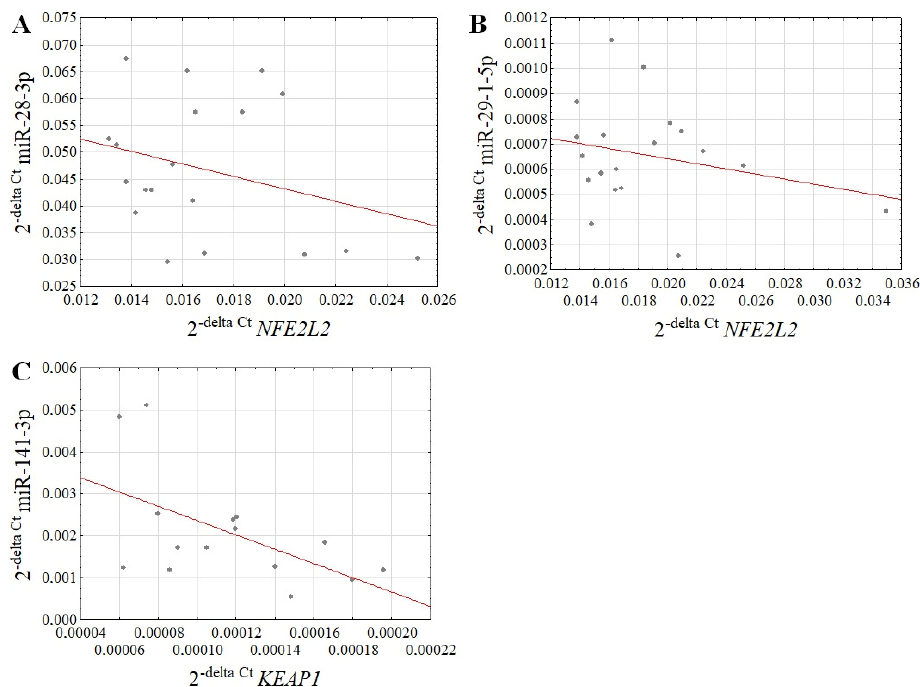
Figure 3. Correlation between the selected mRNA and miRNA: miR-28-3p vs. NFE2L2 ( A ), mir-29-1-5p vs. NFE2L2 ( B ) and miR-14-1-3p vs. KEAP1 ( C ).